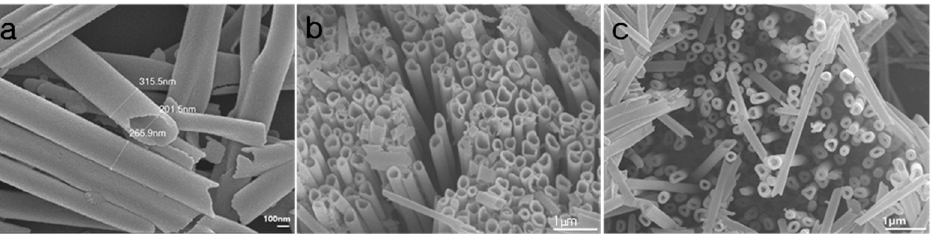
Figure 1. SEM images of ( a , b ) α -Fe 2 O 3 nanotube ( α -NT) from 3 h deposition of Fe(CO) 5 , and ( c ) α - NT from 12 h deposition of Fe(CO) 5 .